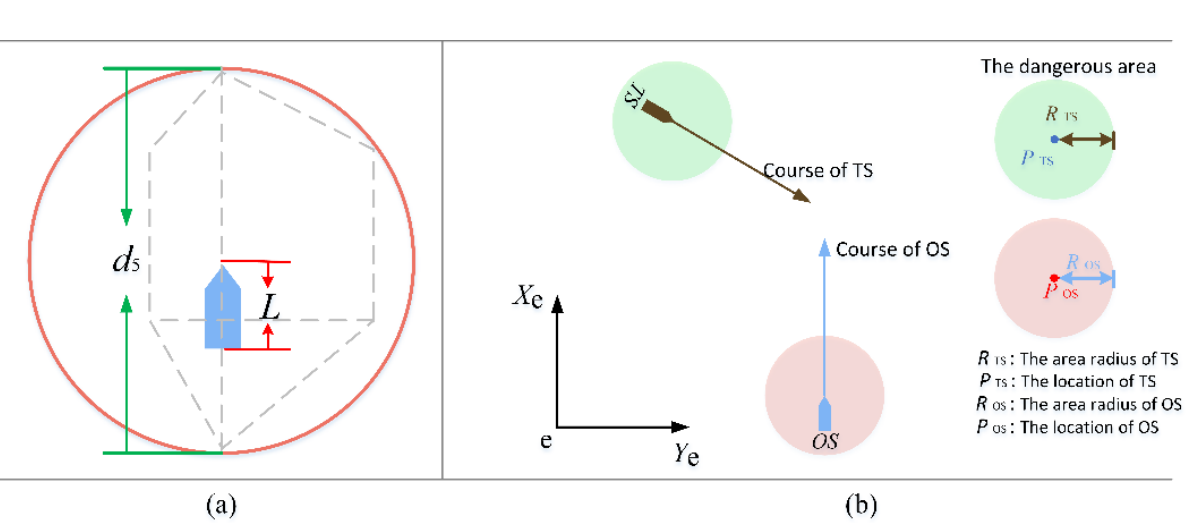
(Figure 3a gray part). The definition of the velocity ob-